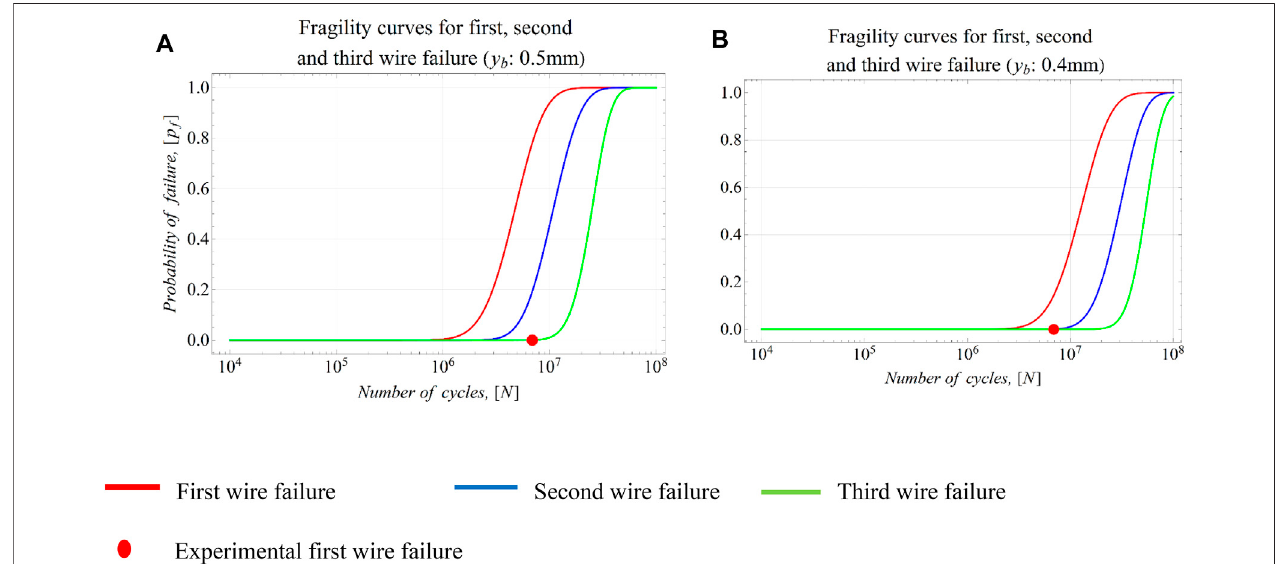
FIGURE 16 | Fragility curves for the Bersfort conductor at a bending amplitude of (A) 0.5 mm and (B) 0.4 mm.